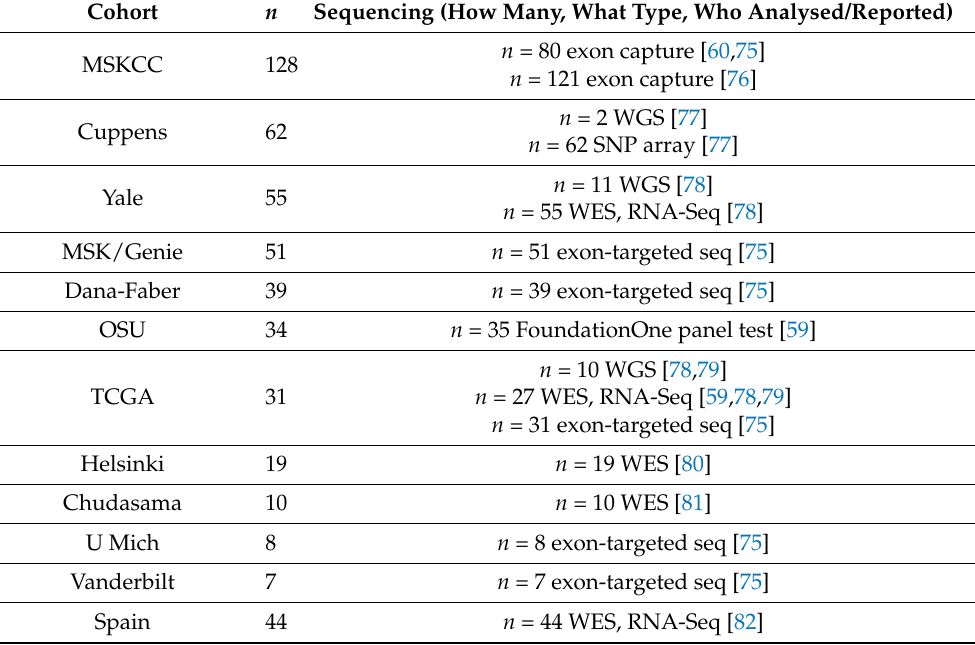
Table 2. Summary of published uLMS patient cohorts for genomic/genetic analysis. Cohort